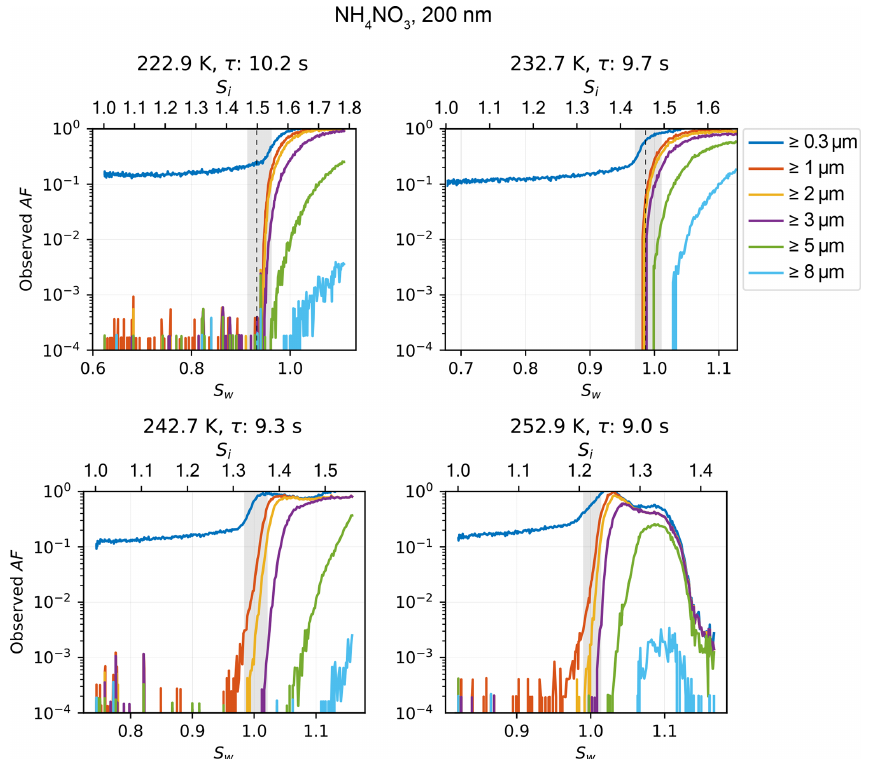
Figure A5. Relative humidity ramps showing the increase in AF during deliquescence and cloud droplet formation of 200nm ammonium nitrate particles at various temperatures. Grey shading refers to chamber uncertainty (see Sect. 3.1 for